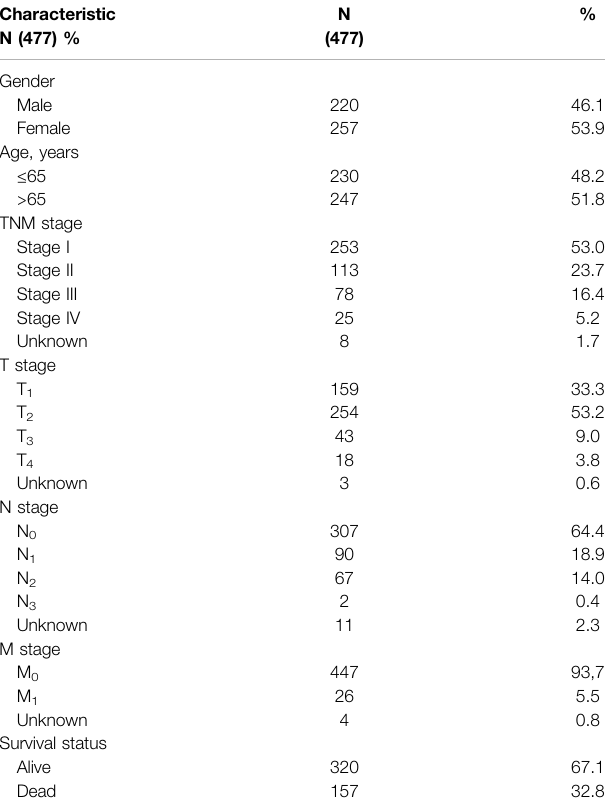
TABLE 1 | Clinical features of selected lung adenocarcinoma (LUAD) patients in TCGA dataset. TCGA, The Cancer Genome Atlas. Characteristic N (477)